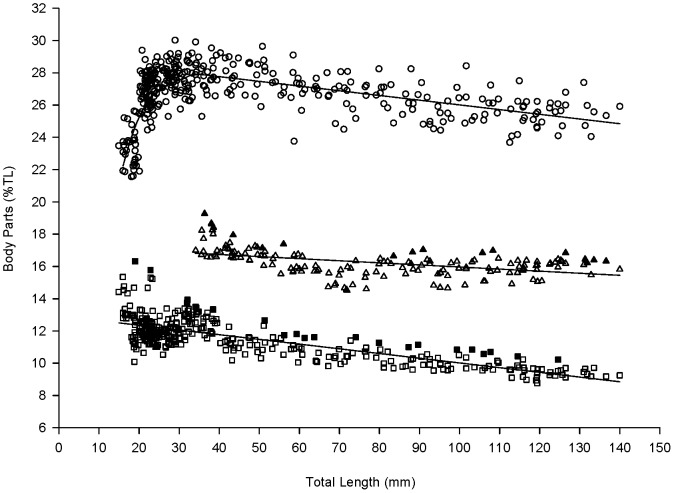
Morphological variation between relative body parts (%TL) and total length (TL, mm) of juvenile barramundi.Body depth (BD in circles, n = 368), closed mouth width (MWc in squares, n = 360) and opened mouth width (MWo in triangles, n = 154) are plotted against total length. Each symbol represents an individual estimate. Filled symbols represent maximum values of mouth width estimates.